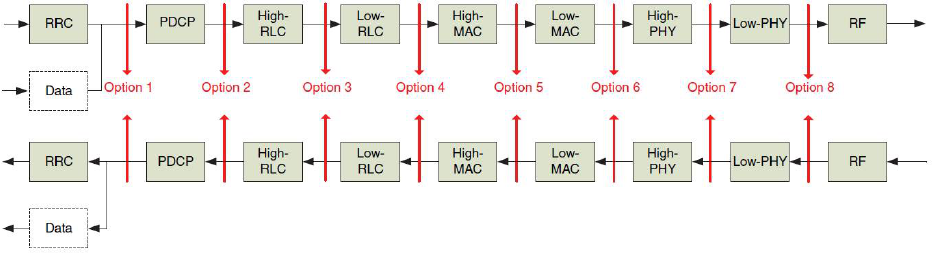
Figure 3. Splitting options in 3GPP specification (Source: 3GPP).